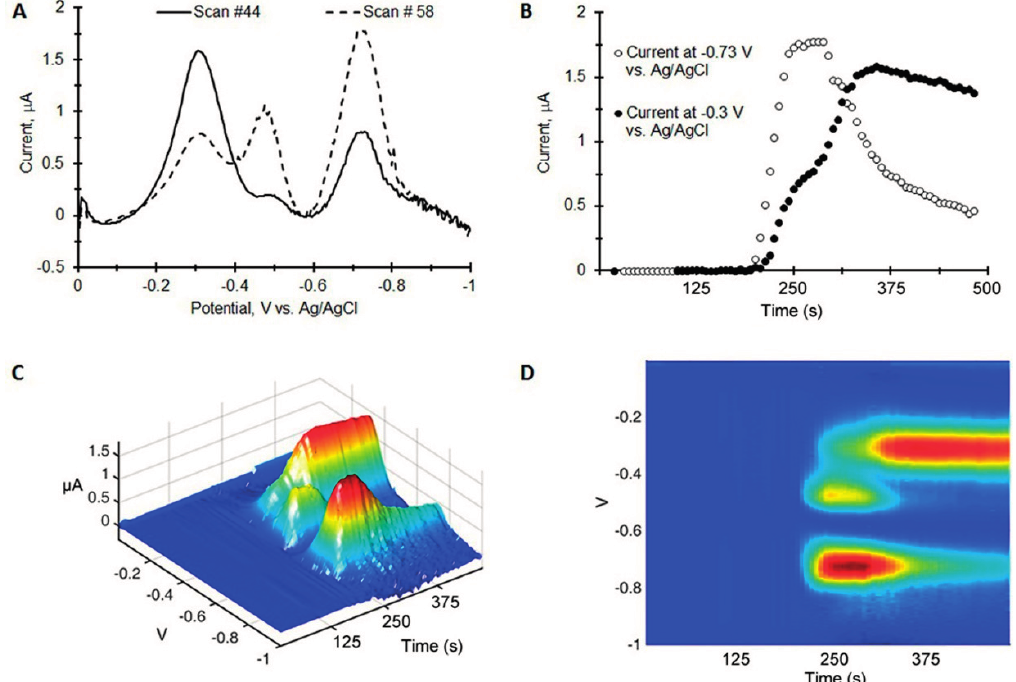
Figure 5. Separation of MeP and TNT in sandy soil. ( A ) Square wave voltammograms at different time points; ( B ) Time traces at two different potentials; ( C , D ) 3D square wave chromato-voltammograms. Parameters: Amplitude = 25 mV, Frequency = 60